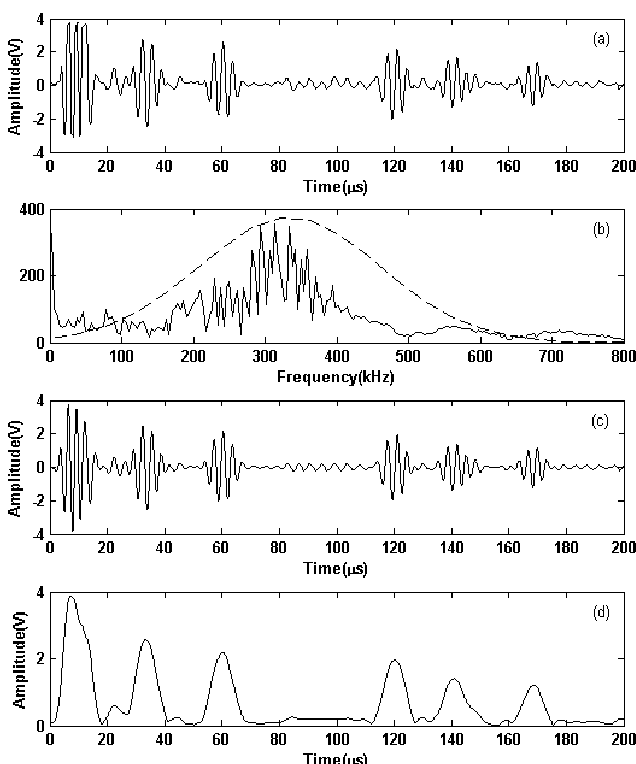
Figure 14. Inspection results in a Ferrum plate when the exciting signals were with center frequencies of 360 kHz and Vpp of 264 V: ( a ) received signals; ( b ) spectra of the received signal (solid lines) and the Gaussian function (dashed lines); ( c ) filtered received signal; and ( d ) Hilbert envelope of the filtered received signal.